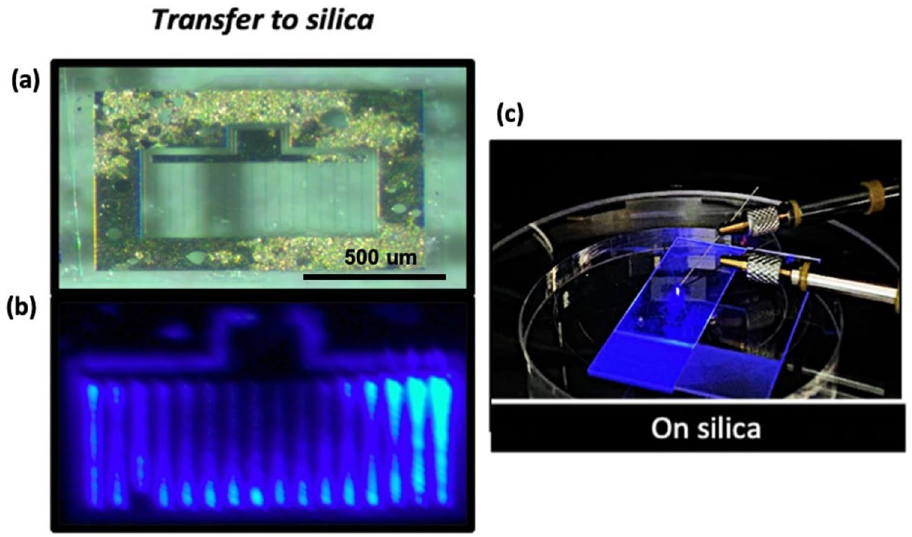
Figure 8. ( a ) Optical microscope image of a patterned LED transferred on a silica plate. ( b ) Corresponding electro-luminescence when a pulsed current is applied to the device. ( c ) Photograph showing the backside emission, guiding and decoupling of the light in the rough surface region of the